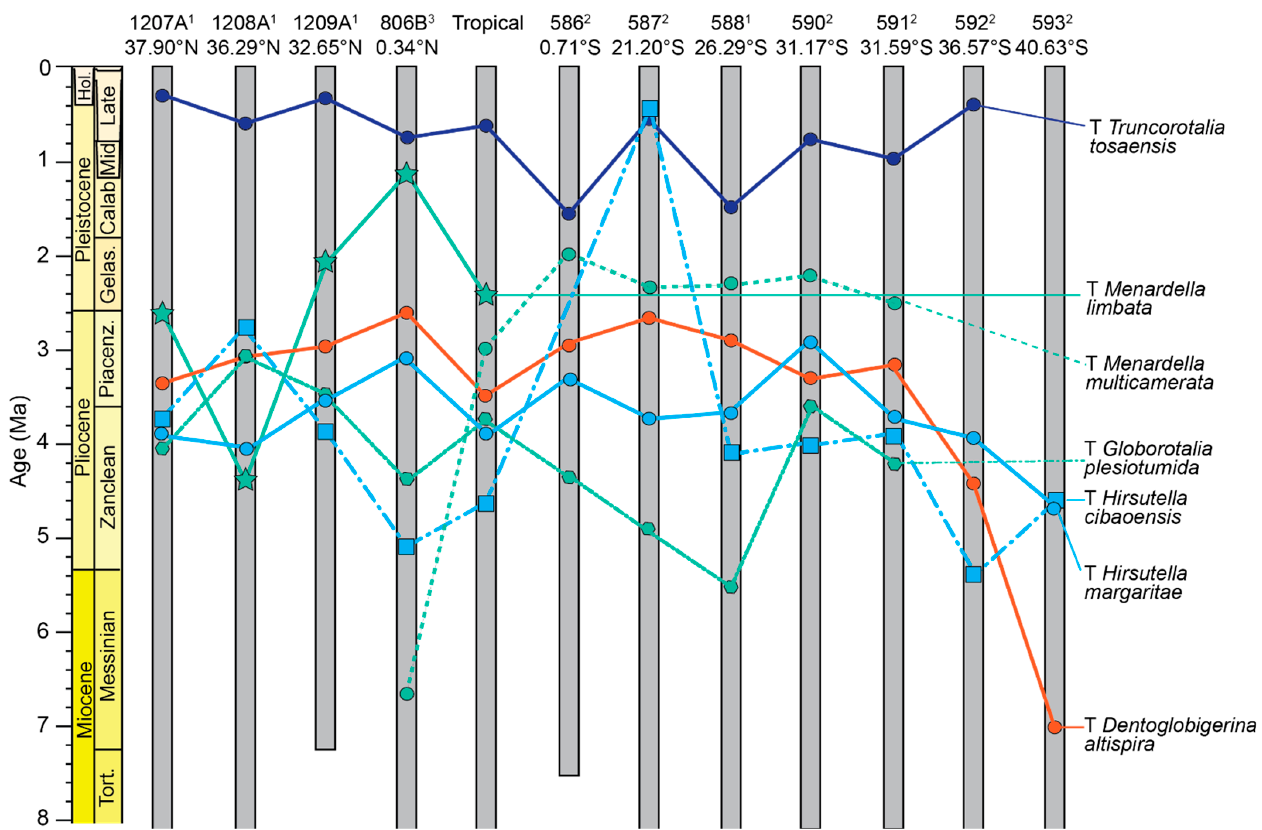
Figure 8. Last occurrences of species used as primary and secondary datums in tropical-to-mid-latitude biostratigraphic zonations belonging to the genera Globorotalia, Hirsutella, Truncorotalia, Menardella, and Dentoglobigerina . Sites are ranked 1–3, as denoted by the superscript number beside each site number. A ranking of 1 indicates that the sites’ age model is based solely on magnetostratigraphy, a ranking of 2 indicates that the sites’ age model is a mix of magnetostratigraphy and biostratigraphy, and a ranking of 3 indicates that the sites’ age model is based solely on biostratigraphy (Supplementary Table S1).